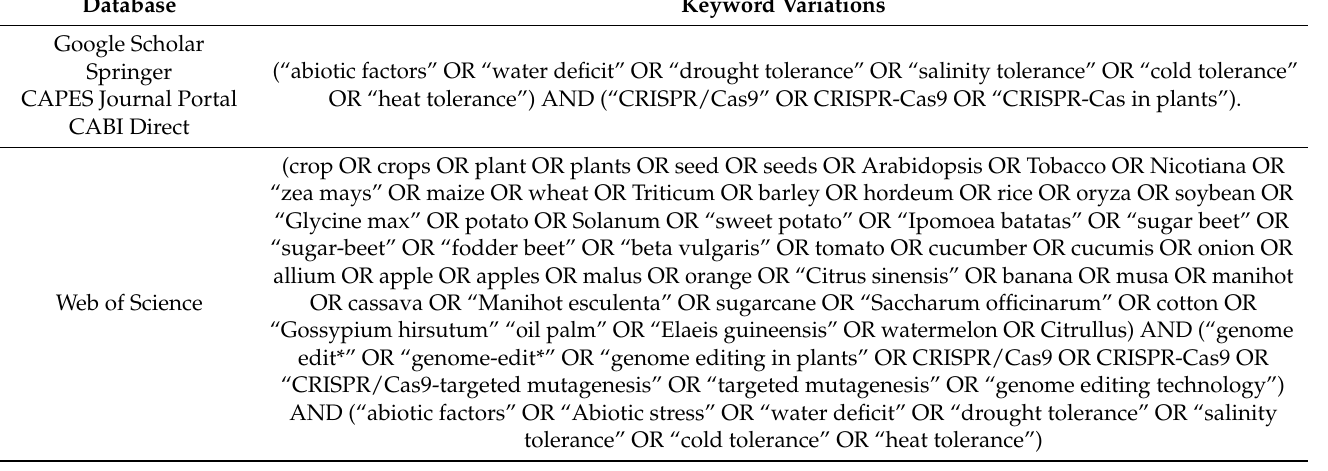
Table 4. Search keywords used for the systematic review of CRISPR/Cas technology in the editing of genes for tolerance to abiotic stresses in plants of the last seven